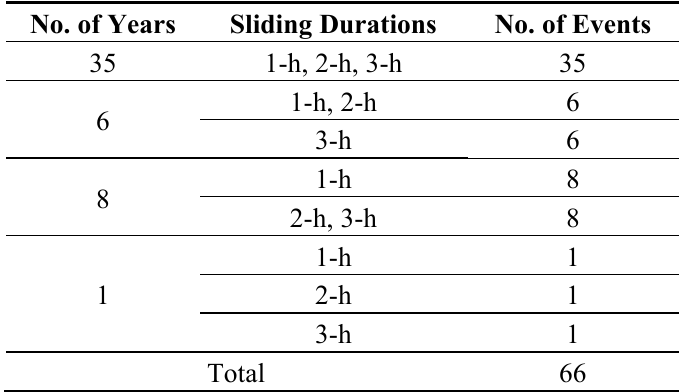
Table 3. Number of events for each sliding